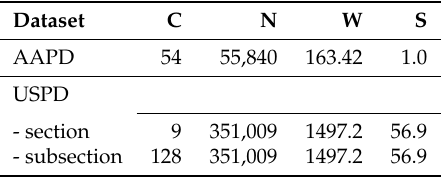
Table 1. Summary of the